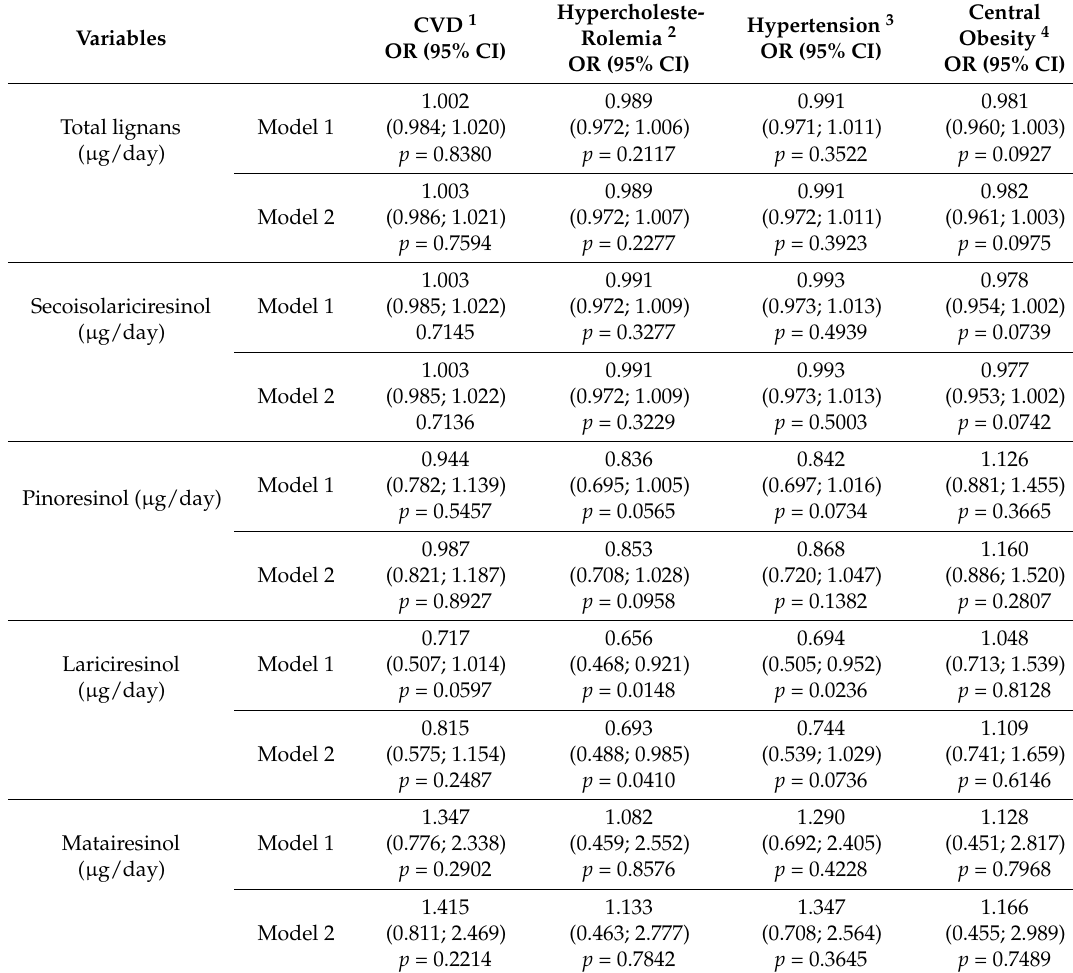
Table 7. Association between total and individual lignan intake and prevalence of CVD, hypercholesterolemia, hypertension and central obesity; multivariable